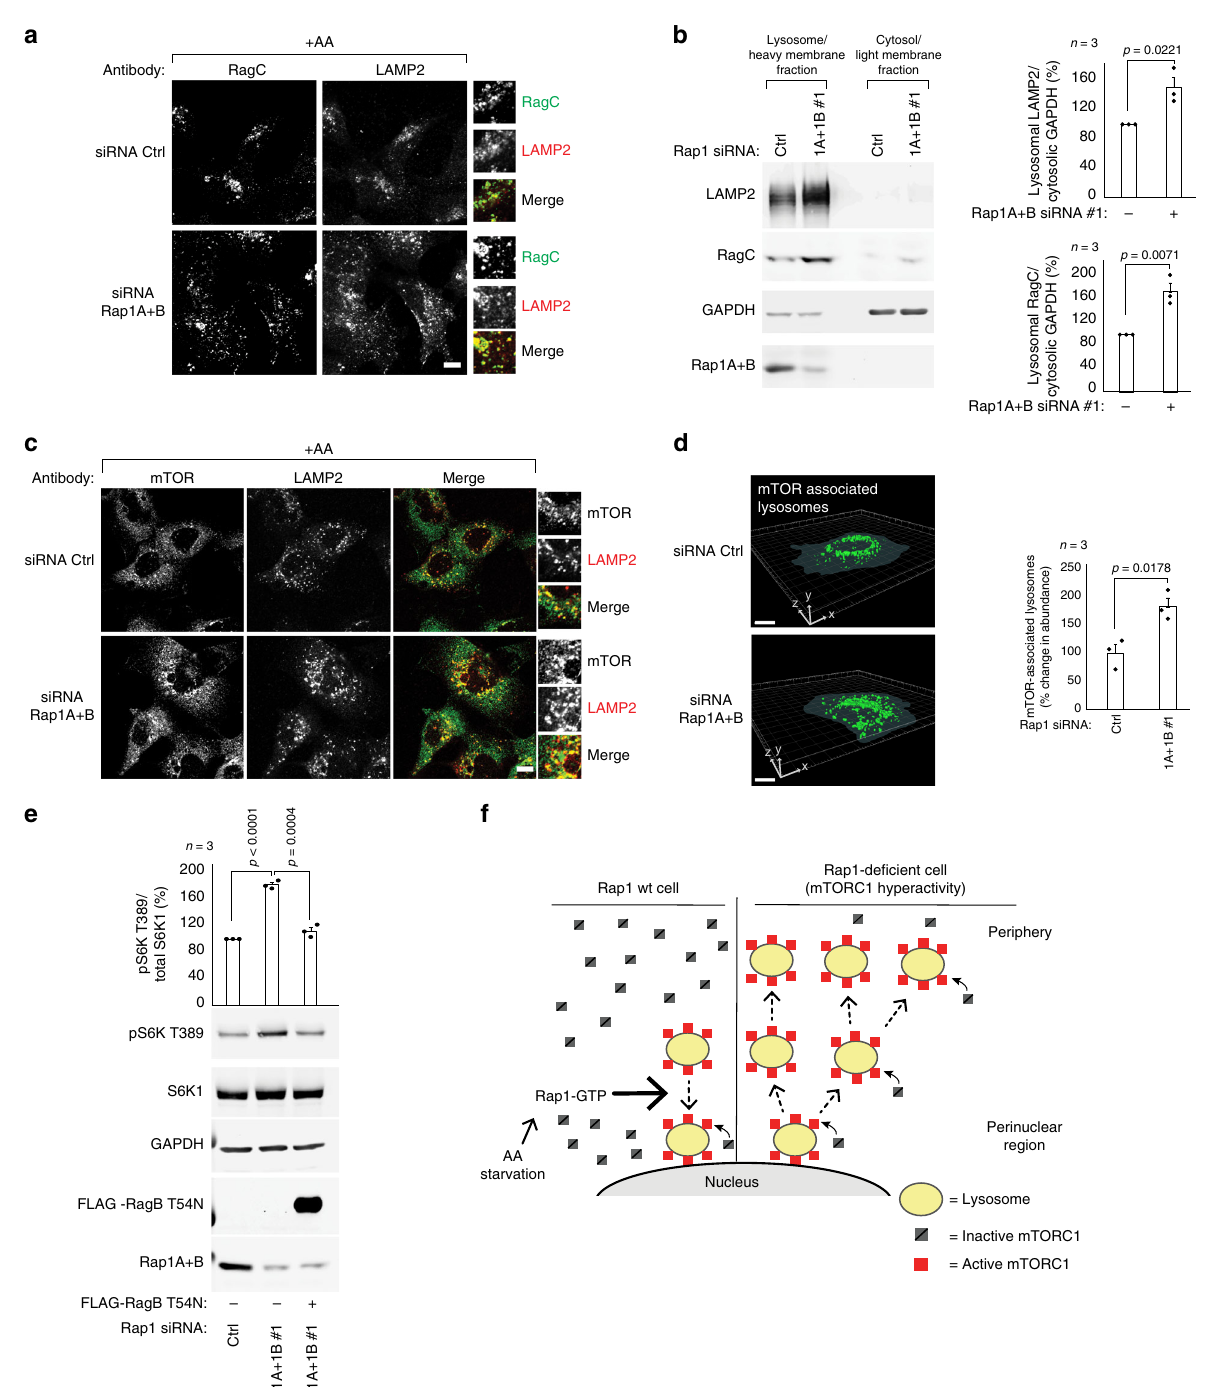
Antibodies . Western blot: The following antibodies were purchased from Cell Signaling Technologies and used in a 1:1000 dilution: phospho p70 S6K1Thr389 (9234), S6K1 (2708), phospho 4E-BP1 Ser65 (9451), mTOR (2983), phospho Akt Ser473 (4060), Akt1 (2967), COX IV (4850), phospho PRAS40 Thr246 (2997), Rap1A + B (2399), Rap1B (2326), phospho AMPKalpha Thr172 (2535), LAMP1 (9091), AMPKalpha (2603), RagA (4357), RagC (3360), RagD (4470), Raptor (2280), p14/LAMTOR2/ROBLD3 (8145). Additional antibodies used in 1:1000 dilution: phospho GCN2 Thr899 (Abcam: ab75836), GCN2 (Novus Biologicals: